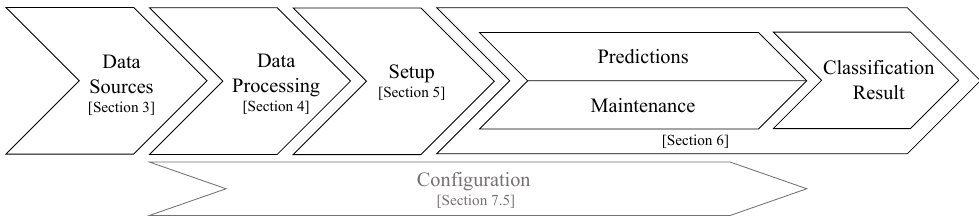
Figure 1. Scheme of the process that is employed by most stream classification